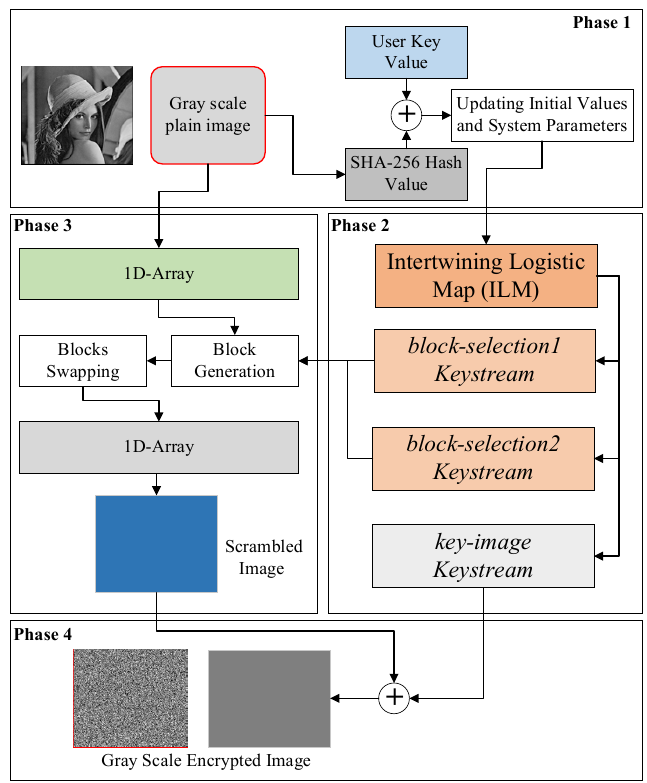
Figure 3. Block-based encryption scheme.